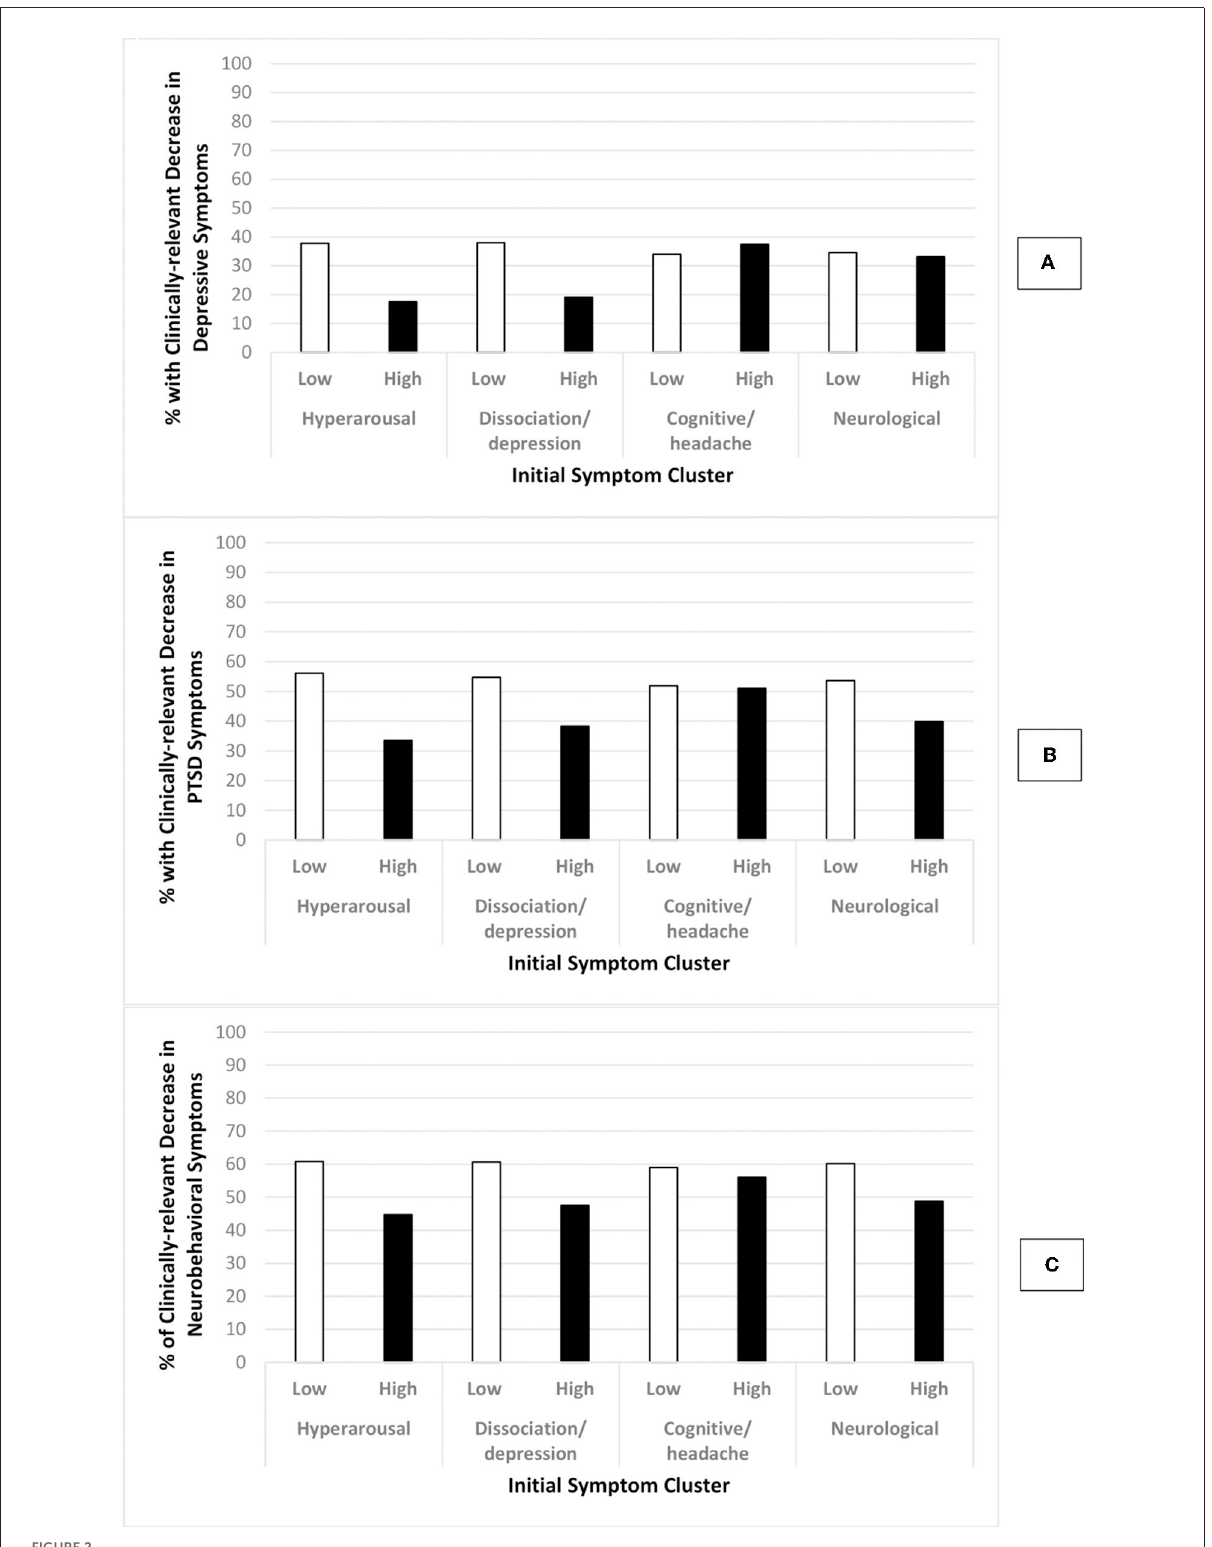
FIGURE2 Percentage of participants with clinically-relevant DECREASE in outcome by level of initial symptoms. Low initials symptoms : total symptom cluster z -score < 1.5; High initial symptoms : total symptom cluster z -score ≥ 1.5; Graph (A) : change in depressive symptoms; Graph (B) : change in PTSD symptoms; Graph (C) : change in neurobehavioral symptoms; Clinically-relevant decrease in outcomes: PHQ-8 ≥ 5, PCL-5 ≥ 7, NSI ≥